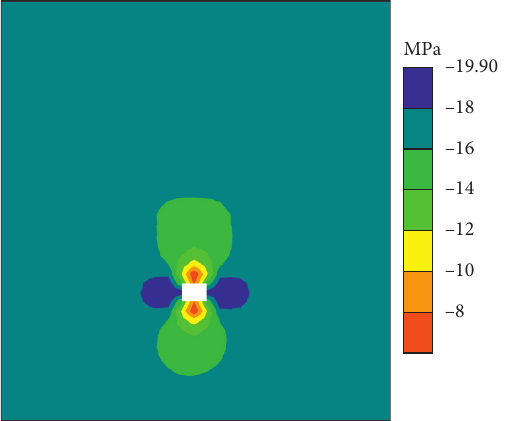
Figure 2: Vertical stress contour in return airway.